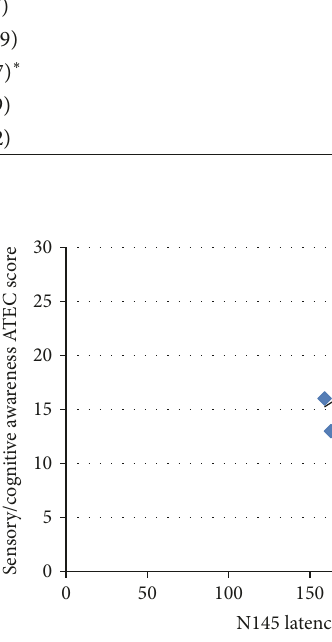
Figure 2: Scatter plot displaying the correlation between N145 latency over Oz electrode and the ATEC scores for subtests in sensory/cognitive